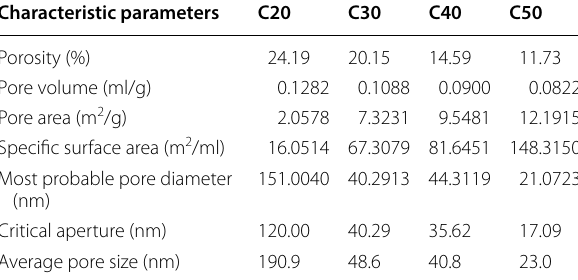
Table 2 The pore structure characteristic parameters of concrete.